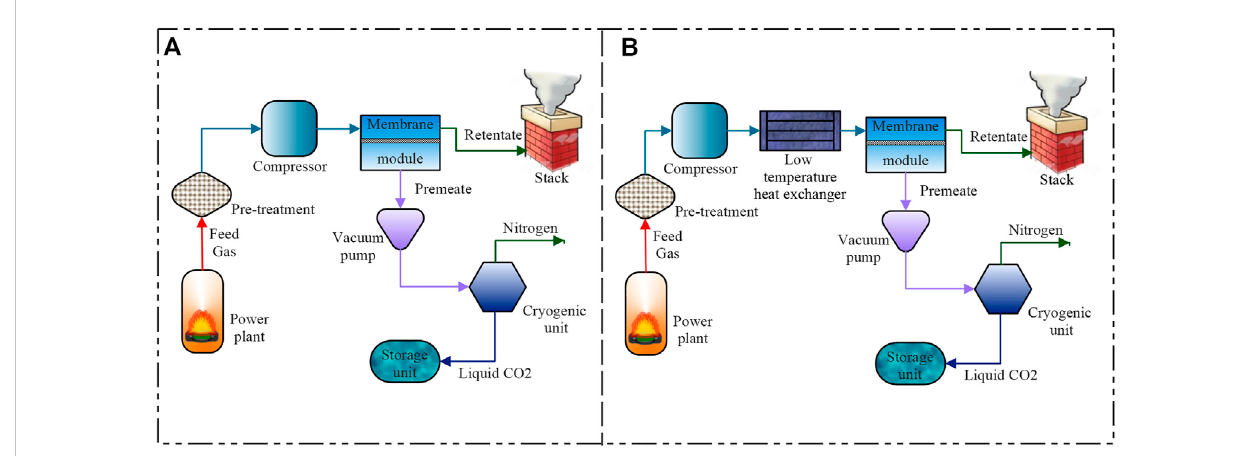
FIGURE 1 Schematic representation of (A) hybrid membrane cryogenic (HMC) process, (B) low-temperature membrane cryogenic (LTMC) process.